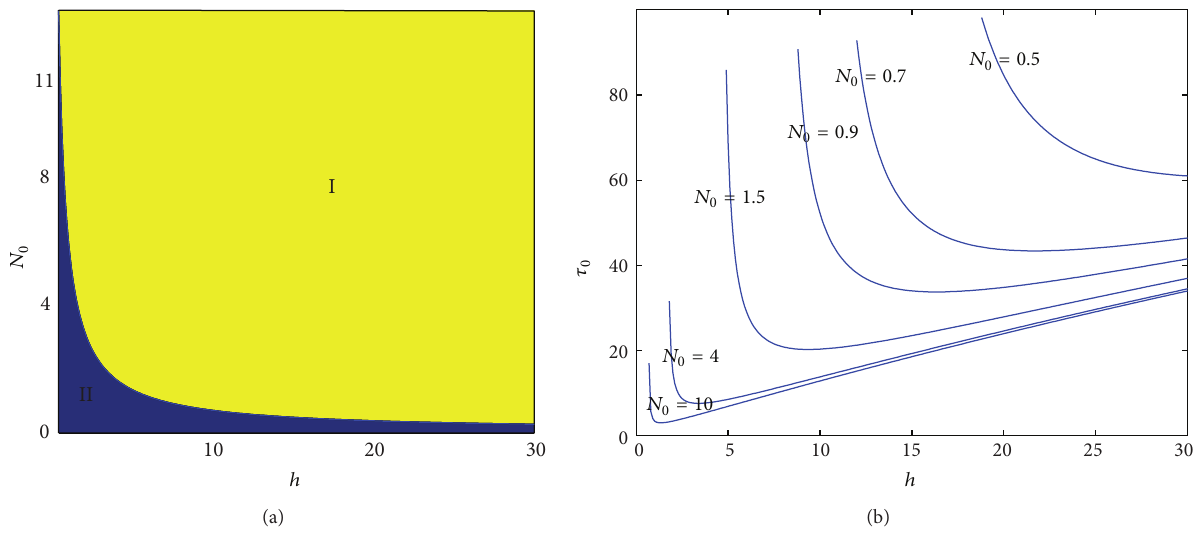
Figure 1: (a) The field where two equilibria exist; (b) the relationship of 𝜏 0 with 𝑁 0 , ℎ .